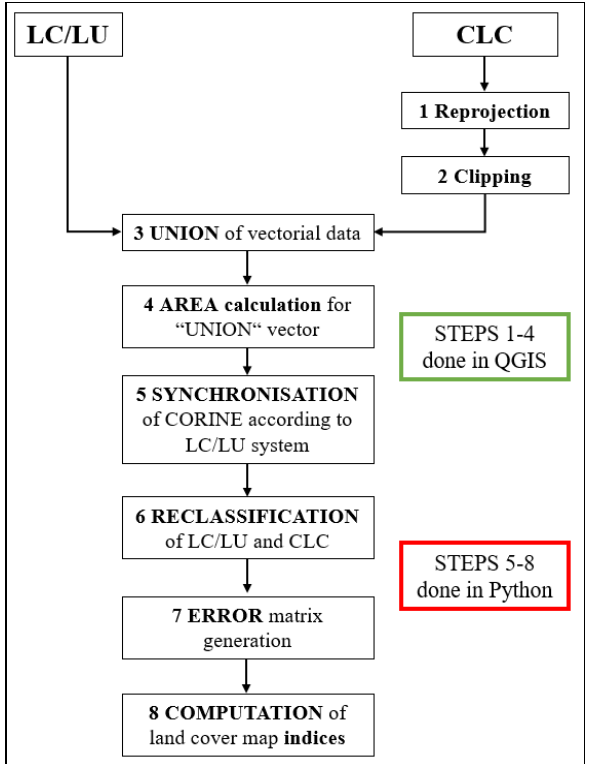
Figure 4 . The complete workflow of data